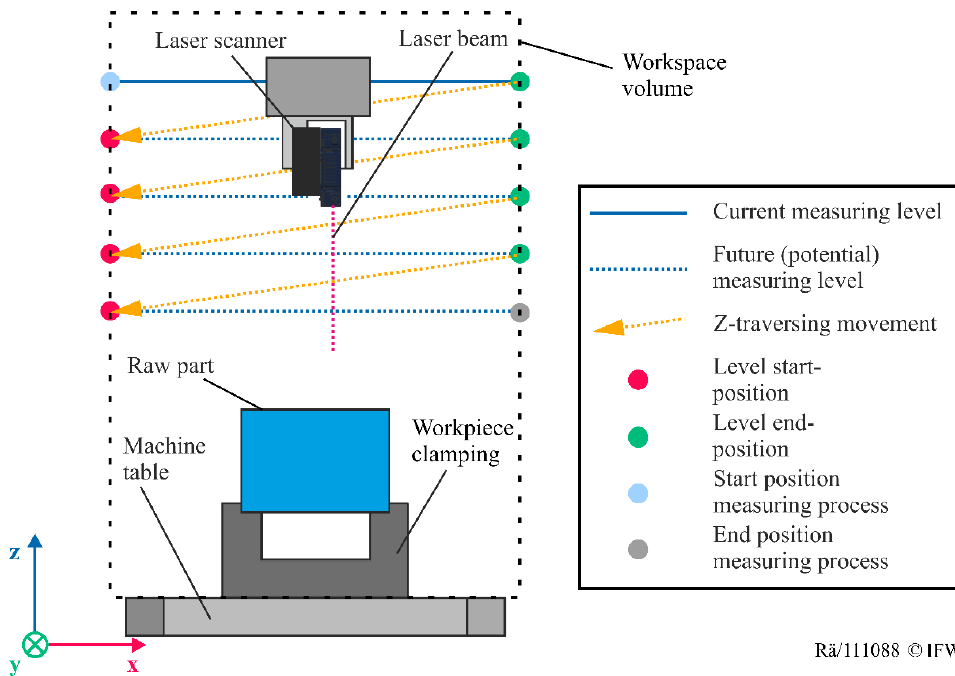
Figure 3. Z-interval decomposition of the sensor path planning.